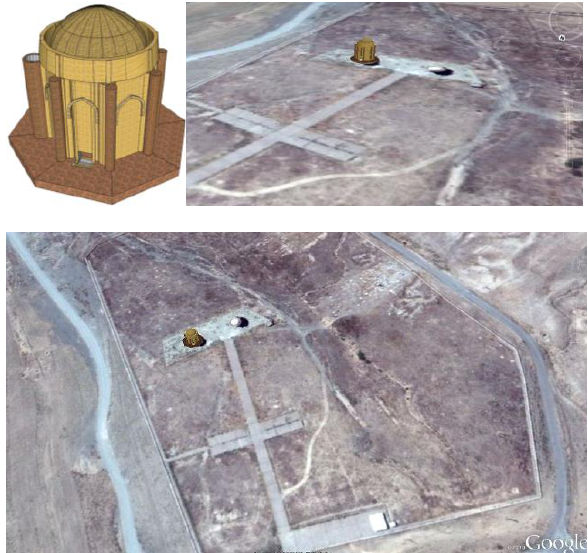
Figure 10. Different views of the 3D model of the tower in Google-earth map